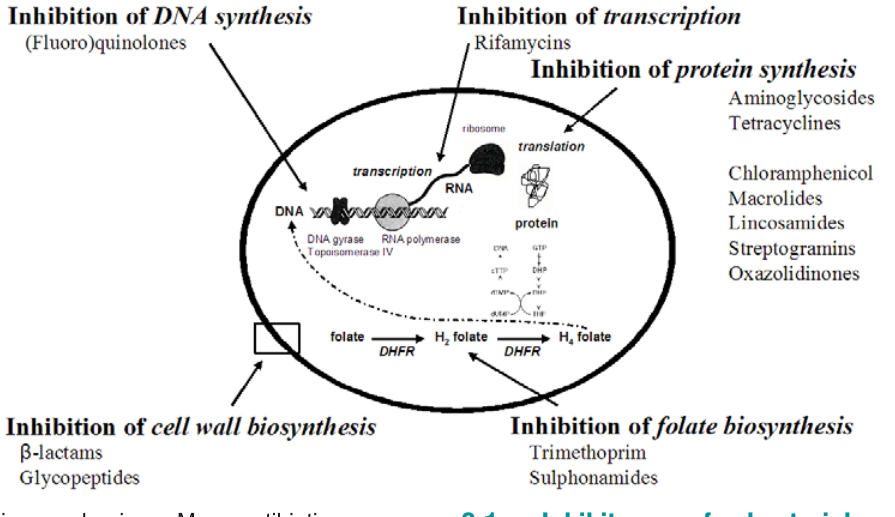
Figure 2. Actually used targets for antimicrobial